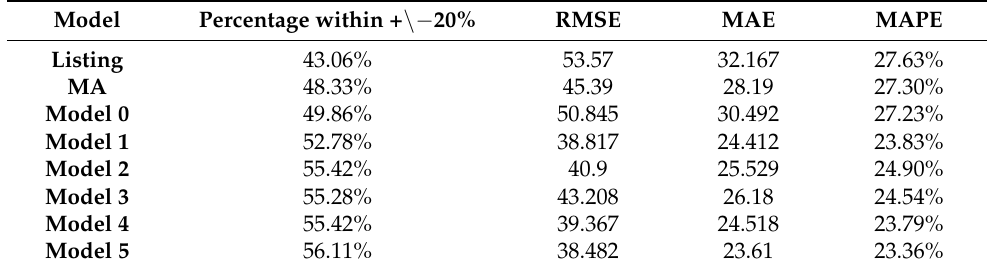
Table 5. SH-2 Accuracy & Error Metrics Comparison of